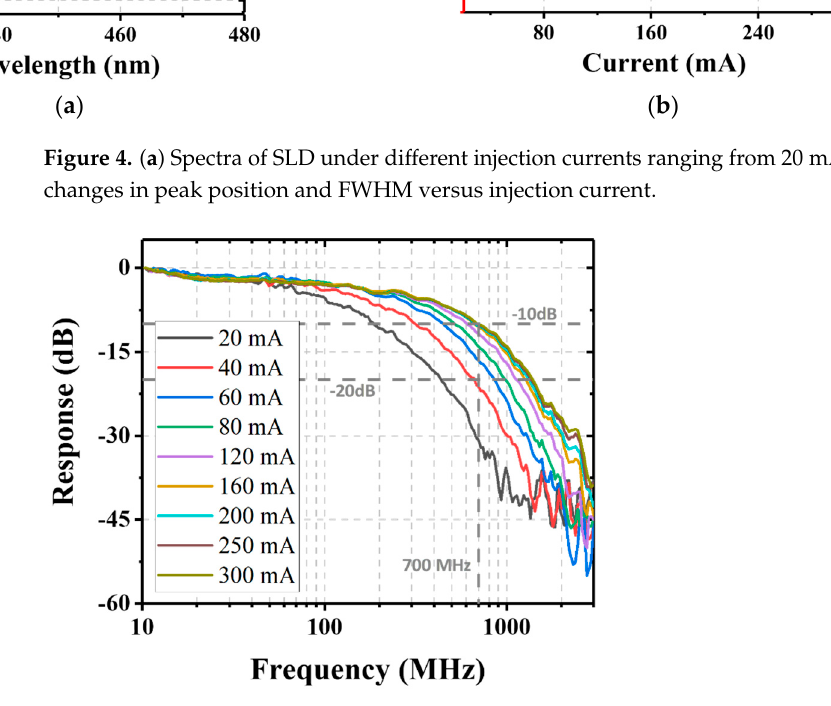
Figure 5. The frequency response of the blue SLD-based VLC system.